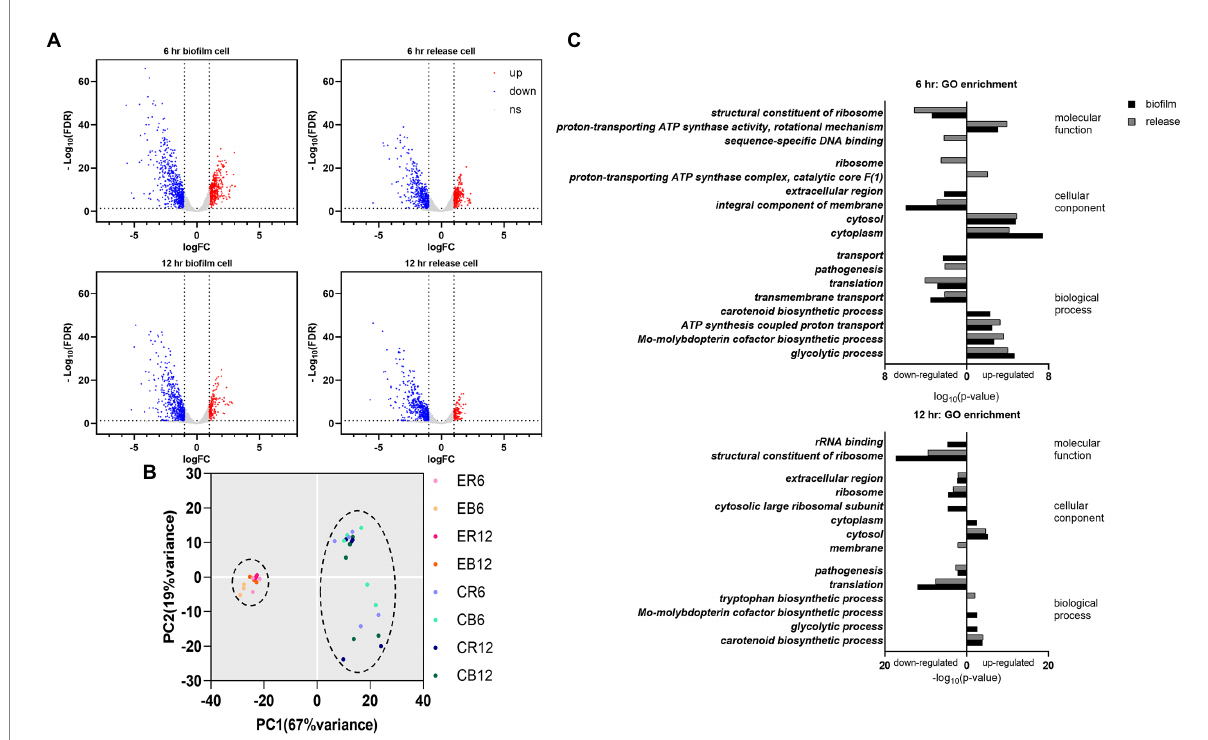
FIGURE 3 Changes in the gene expression of MRSA cells after elasnin treatment. (A) Volcano plot of RNA-seq profiles of MRSA cells showing the altered gene expression pattern of collected samples (up: upregulated, corresponding to the red dots; down: downregulated, corresponding to the blue dots; ns: not significantly changed, corresponding to the gray dots). (B) Principal component analysis of RNA-seq samples (treated with elasnin and untreated), in which elasnin treatment mainly caused the altered gene expression. ER: cells released from elasnin-treated biofilms; CR: cells naturally released from the biofilms; EB: elasnin-treated biofilms cells; CB: biofilm cells. The numbers following the letters indicate the duration of elasnin treatment (in hour). (C) Gene ontology enrichment analysis of differentially expressed genes (in biofilm and released cells, marked by black and gray bars, respectively), highlighting the alterations in genes for pathogenesis and those located in the extracellular region and the integral component of the